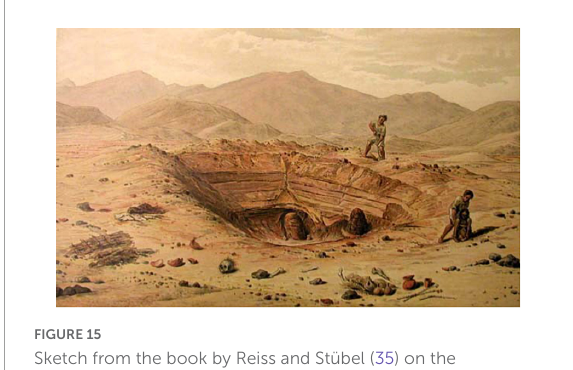
FIGURE15 Sketch from the book by Reiss and Stübel (35) on the excavations and findings at the necropolis of Ancon, Peru. As it was typical at the end of the 19th/beginning of the twentieth century, the content of graves was examined on the spot: mummy bundles and objects worth selling were taken away, invaluable items